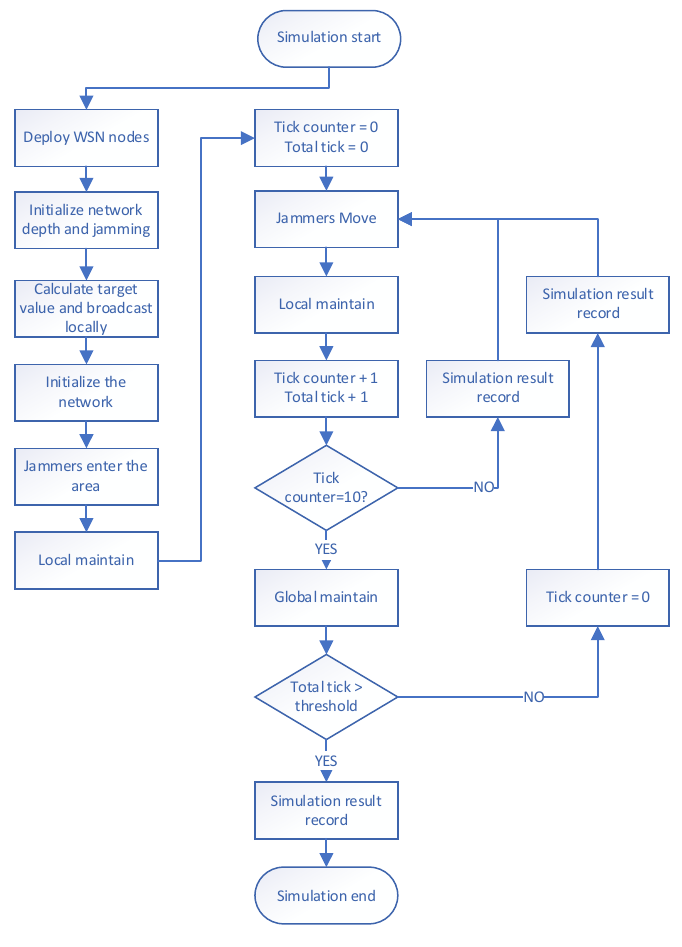
Figure 4. Simulation